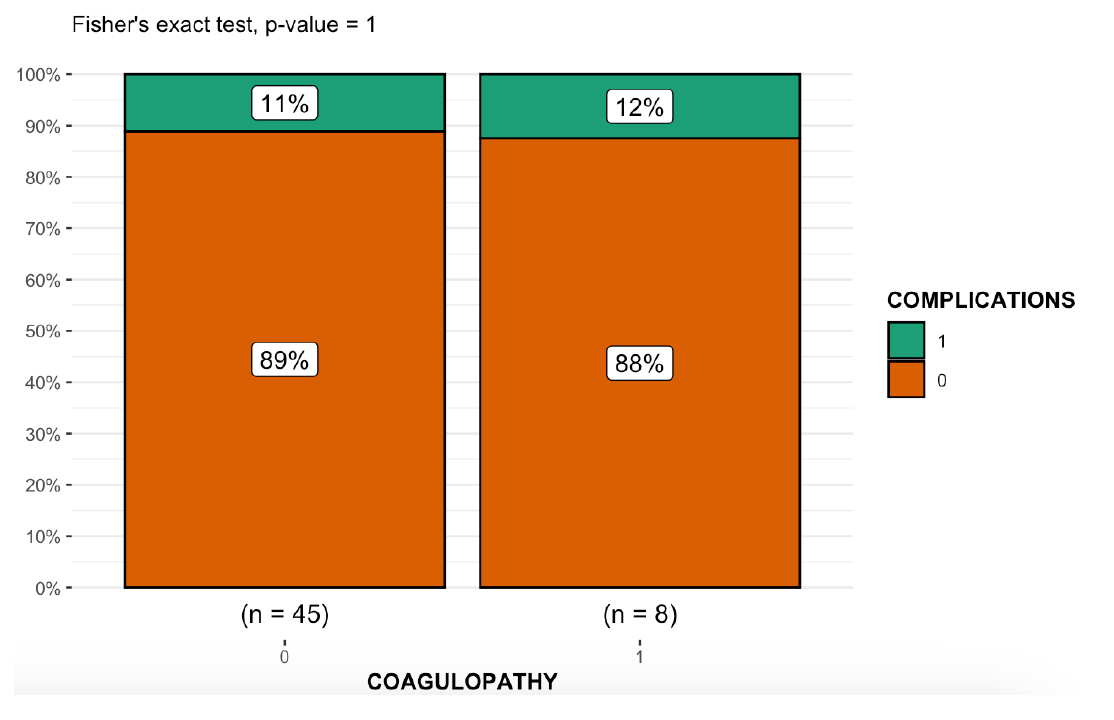
Figure 5. Boxplot representing the relationship between the two categorical variables, “Coagulopa- thy” and “Complications”, analyzed using Fisher’s exact test.